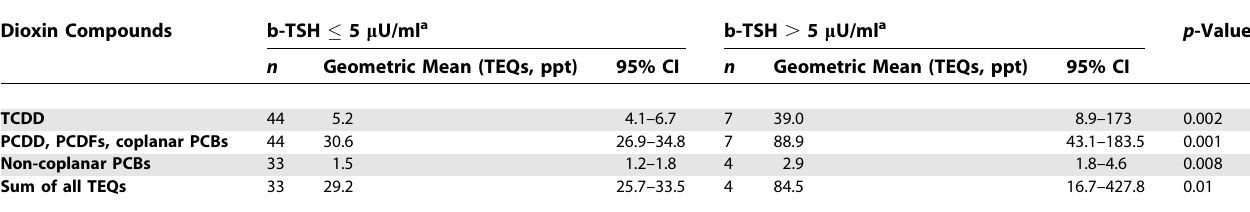
Table 5. Plasma Levels of Dioxin Compounds by b-TSH Levels ( (cid:2) 0.5 l U/ml or . 5 l U/ml) Dioxin Compounds